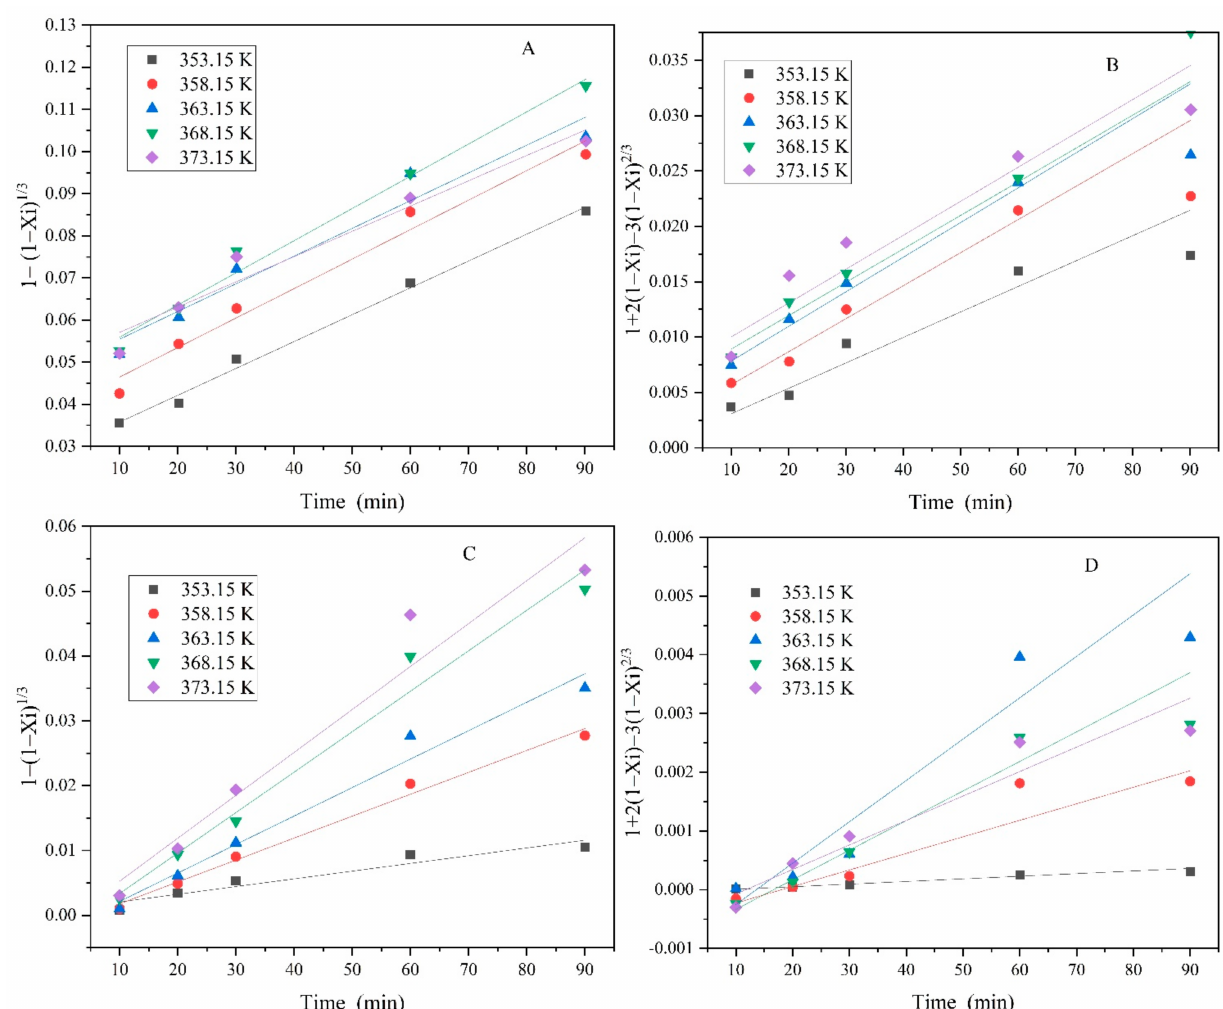
Figure 8. Leaching kinetics of different elements in oxalic acid: ( A ) V using the surface chemical reaction control model; ( B ) V using the diffusion control model; ( C ) Ni using the surface chemical reaction control model; ( D ) Ni using the diffusion control